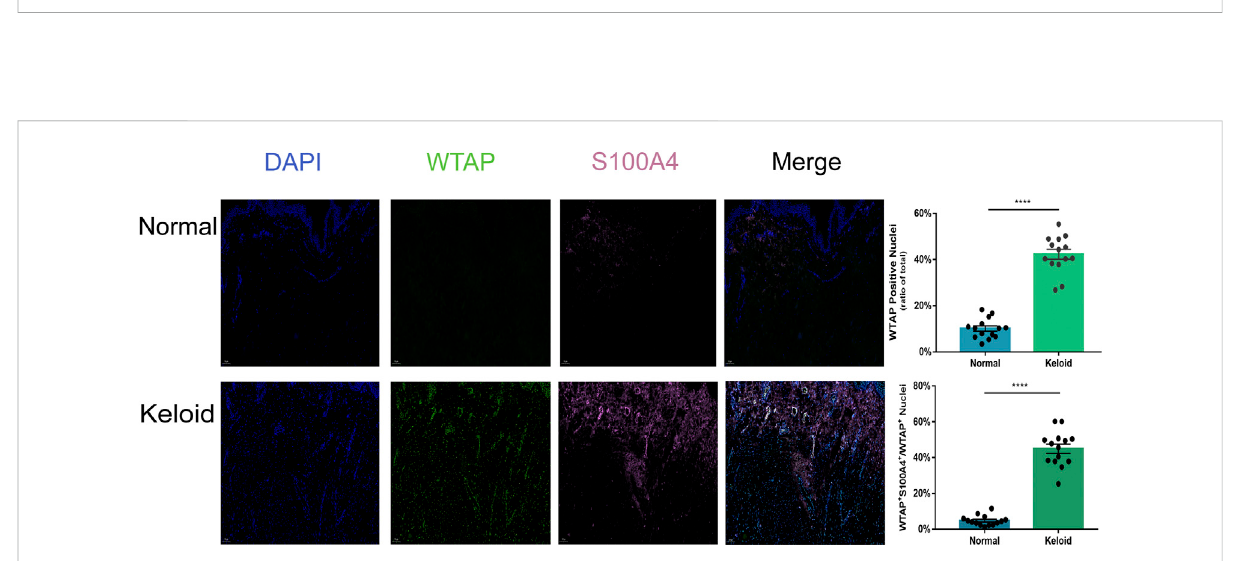
FIGURE 5 Positive effects of hypermethylation on the expression of fi broblasts in keloid. Three-color immuno fl uorescence confocal images were obtained for WTAP (green), S100A4 (pink), and nuclei (blue) in normal skin and keloid. The images were merged at last. The two bars show that the proportionofthecellswithWTAPstainingandthecellswithbothpositivestainingofWTAPandS100A4inkeloidweresigni fi cantlyhigherthanthose in normal skin. **** p <